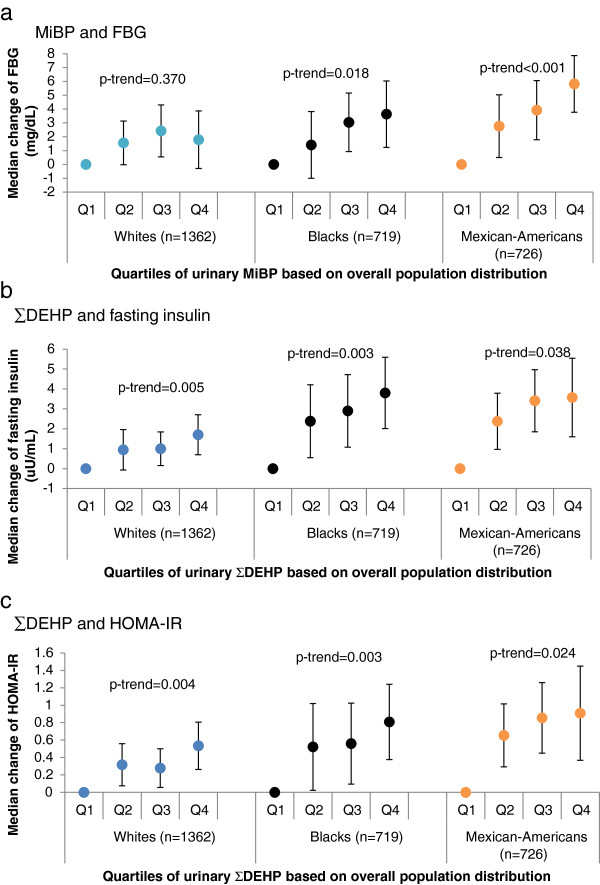
Change in markers of diabetes risk across quartiles of urinary phthalate metabolites in racial/ethnic subgroups. One example is selected for each diabetes biomarker, and similar racial/ethnic patterns were seen for other urinary phthalate metabolites, particularly MnBP, MiBP, MCPP and ∑DEHP. (a) example of FBG: MiBP and FBG, (b) example of fasting insulin: ∑DEHP and fasting insulin, (c) example of HOMA-IR: ∑DEHP and HOMA-IR. Adjusted for age, sex, urinary creatinine, fasting time, total caloric intake, triglyceride, education, smoking status and poverty for all phthalate metabolites.